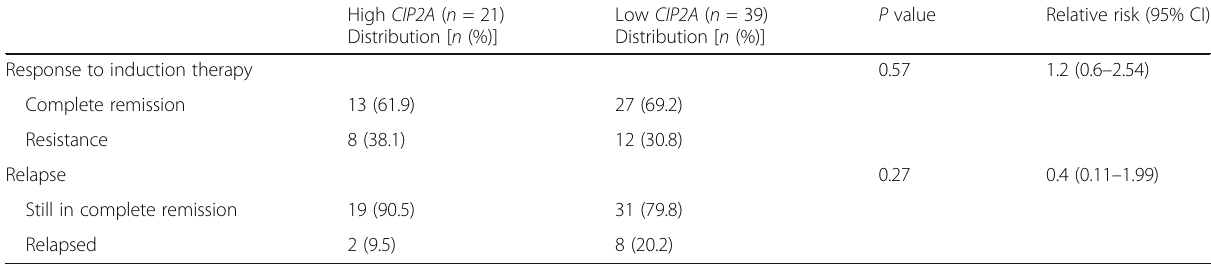
Table 3 Association between CIP2A expression in patients with acute myeloid leukemia and the response to induction therapy and the relapse rate